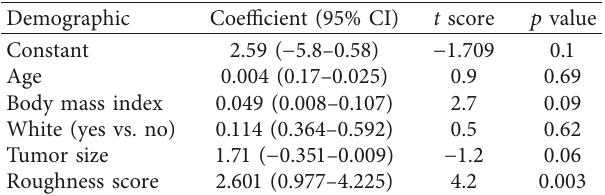
Table 2: Multivariable linear regression model or the outcome of kidney cancer